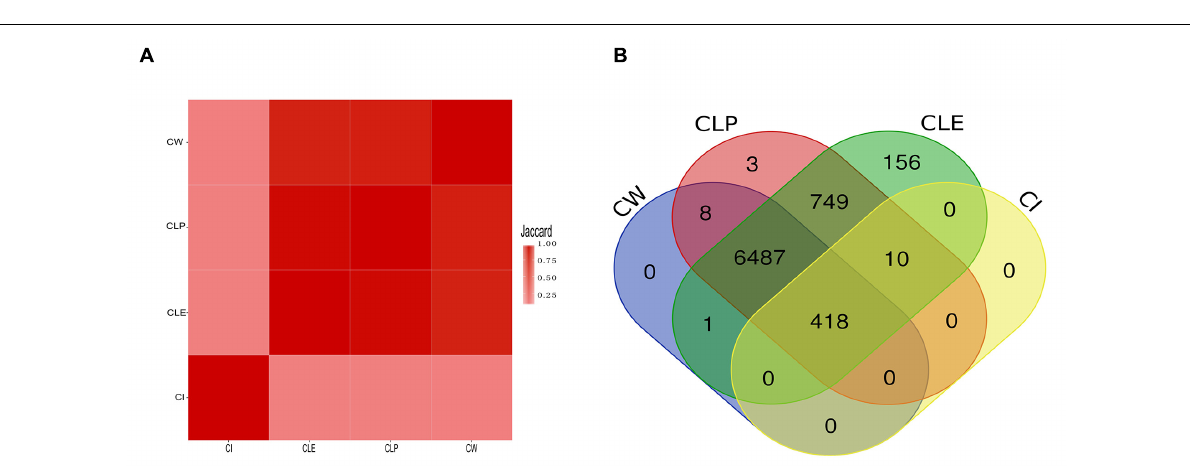
FIGURE 3 | The similarity among the big clusters that were detected by four community detection methods. (A) The heatmap illustrates the Jaccard value of all big clusters of two algorithms. (B) The overlap of protein members that are clustered in big cluster among algorithms. All proteins in big clusters of CW and CI are shared with big clusters produced by CLE and CLP, while CLE and CLP contain its specific proteins in the big